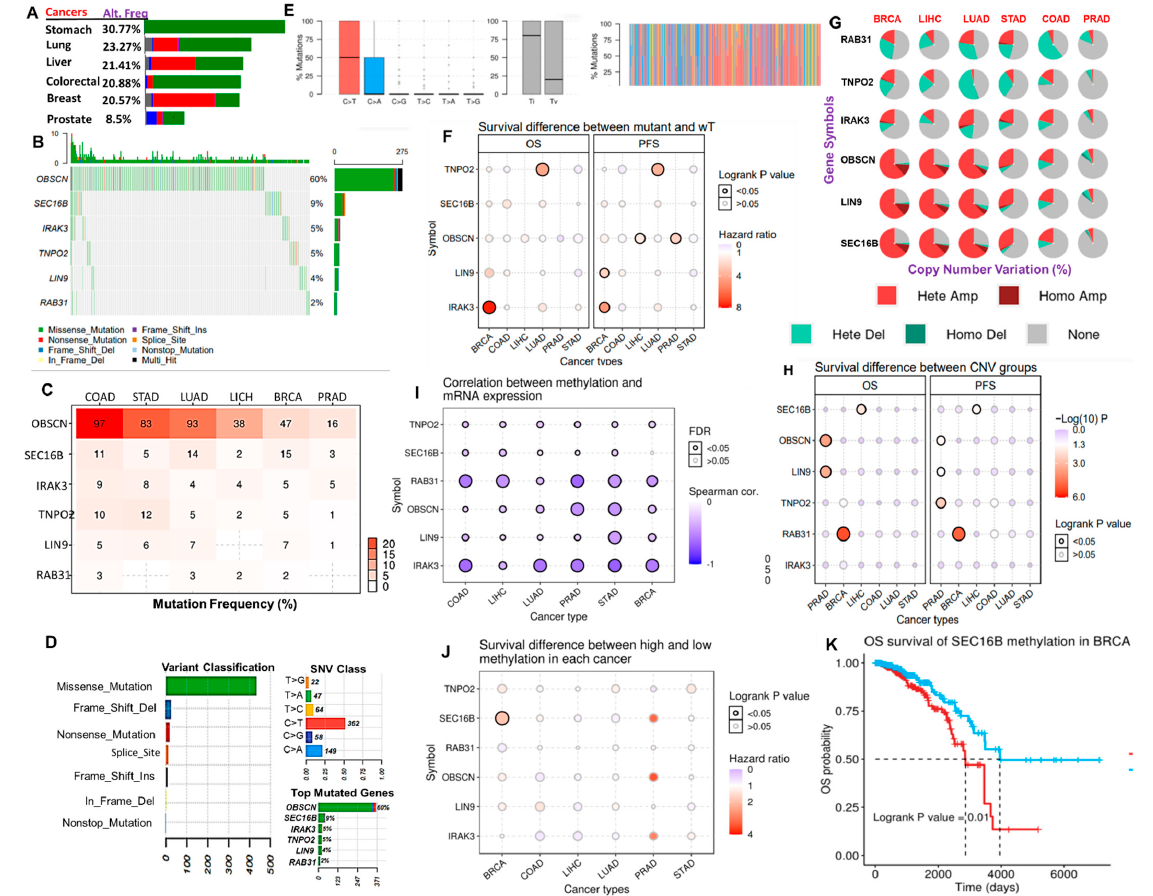
Figure 5. Genetic and epigenetic alterations of the cancer hub genes across the cancer types. ( A ) The bar plot showing the distribution of genetic alteration frequency of the hub gene set across the six cancer types. ( B ) The waterfall plot showing the mutation distribution of the hub genes in the hub cancers. ( C ) Bar plot showing the percentage mutation frequency of each of the genes across the six cancer types. ( D ) The summary plot of the count and type of variants in the sample and gene levels. Plot 1 (Variant Classification) shows the count of each type of effective mutation. Plot 2 (SNV class) shows the count of each SNV class of the hub gene set in the six cancer types. Plot 3 (top mutated genes per sample) shows the top mutated genes. ( E ) The Titv plot showing the distribution of transitions (Ti; A <-> G and C <-> T) and transversions (Tv) mutations of the hub gene set in the hub cancers. ( F ) The bubble plot showing the patient survival differences between the mutant and wild type of the six gene hub in the six cancer types. ( G ) A pie plot showing the proportion of different types of CNV of each of the genes in each cancer. ( H ) Bubble plot of the survival difference between each gene CNV (amplification, deletion, and wide type). The color from blue to red and the bubble size represent the statistical significance. The black outline border indicates Log-rank p < 0.05. ( I ) Bubble plot showing the correlation between methylation and mRNA gene expression. The blue bubbles represent negative correlations, while the bubble size represents statistical significance. ( J ) The bubble plot and ( K ) Kaplan–Meir curve showing the single gene survival result between cohorts with high and low methylation levels of the hub genes; the color from blue to red correlates with the hazard ratio and the bubble size represents statistical significance. The black outline border indicates Log-rank p < 0.05.